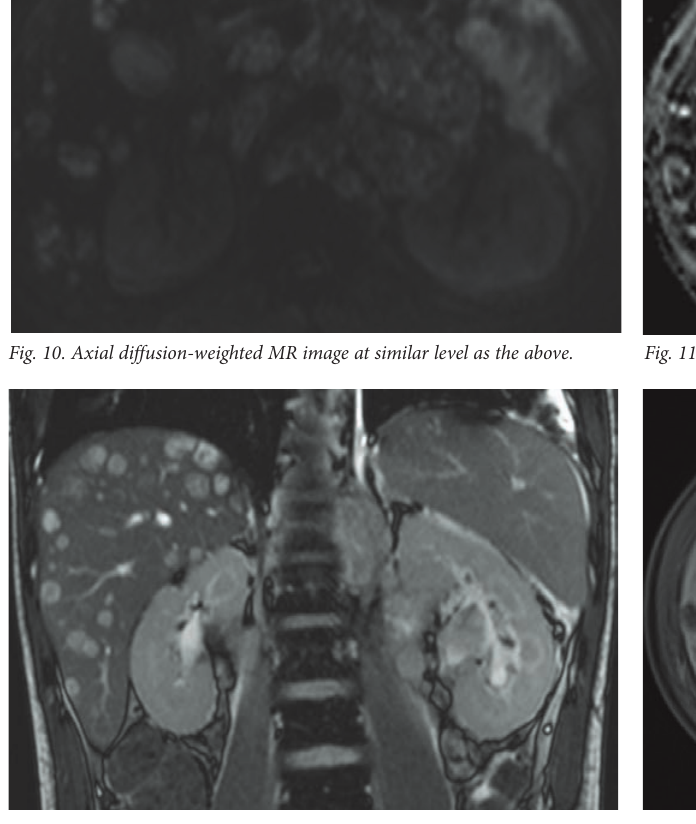
Fig. 12. Coronal T2-weighted MRI image at the epigastric region including costophrenic